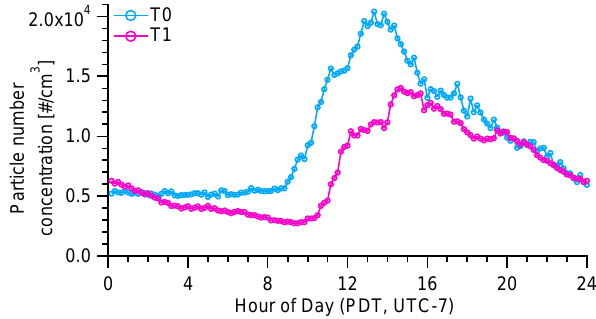
Figure 2. Diurnal patterns of particle number concentrations mea- sured at the T0 and T1 sites during NPE